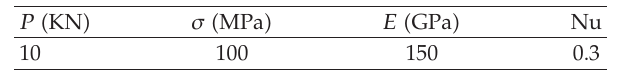
Table 2: Loading and material